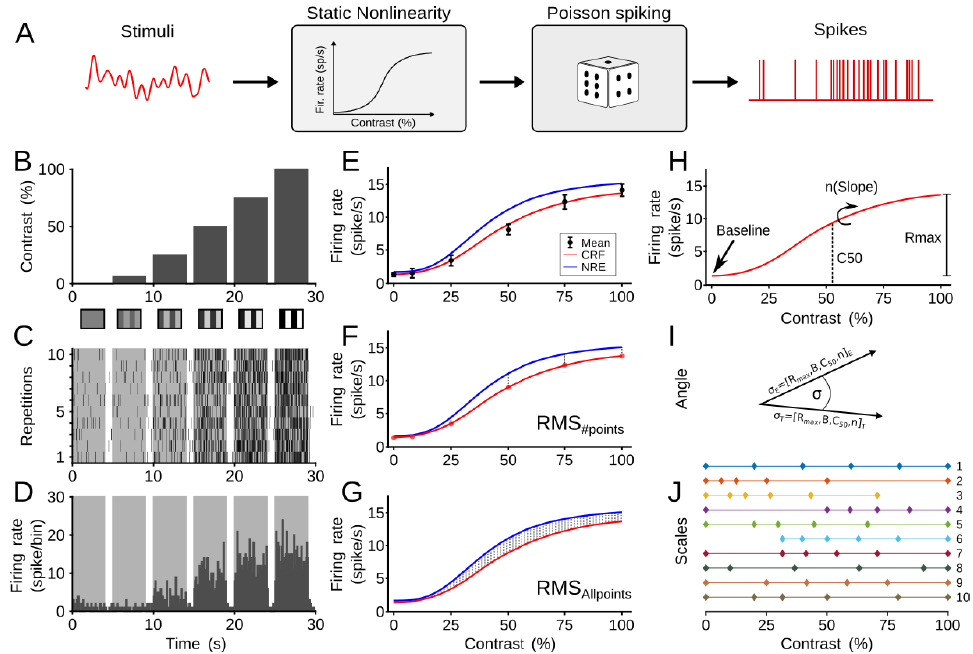
Figure 2. Simulating CRFs. ( A ) Model showing the spiking response to variation of visual contrast. Spikes were generated using an inhomogeneous Poisson process. For more explanations, see Section 2. The model is tested with different contrast magnitudes. ( B ) Visual contrast changing as a function of time. Visual contrast stimuli were presented randomly, but are shown aligned for better visualization. ( C ) Spike response to variations of contrast stimuli. ( D ) Peri-stimulus time histograms generated in order to confirm contrast responses. ( E ) CRF response based on the model output from the firing rate of the simulated neuron. The blue line indicates the theoretical curve with fixed contrast response parameters from the NKE. Black dots show average responses of spiking firing rate to a given contrast. The red line shows the CRF fit from the least-squares curve fitting. Testing conditions were preemptively determined and varied (stimulus trial length, number of trials, number of points). ( F ) Calculation of RMS #points by comparing particular CRF points to the theoretical curve (red dots). ( G ) Calculation of RMS Allpoints by comparing all experimental CRF points to the theoretical curve. ( H ) Calculation of experimental parameters from the CRF fit ( R max , B, C 50 , and n ). ( I ) Calculation of the angle formed by the difference between theoretical and experimental parameters’ vectors. ( J ) Ten scales (metrics) with different contrast distributions are shown. Only scales of 6 points are represented.